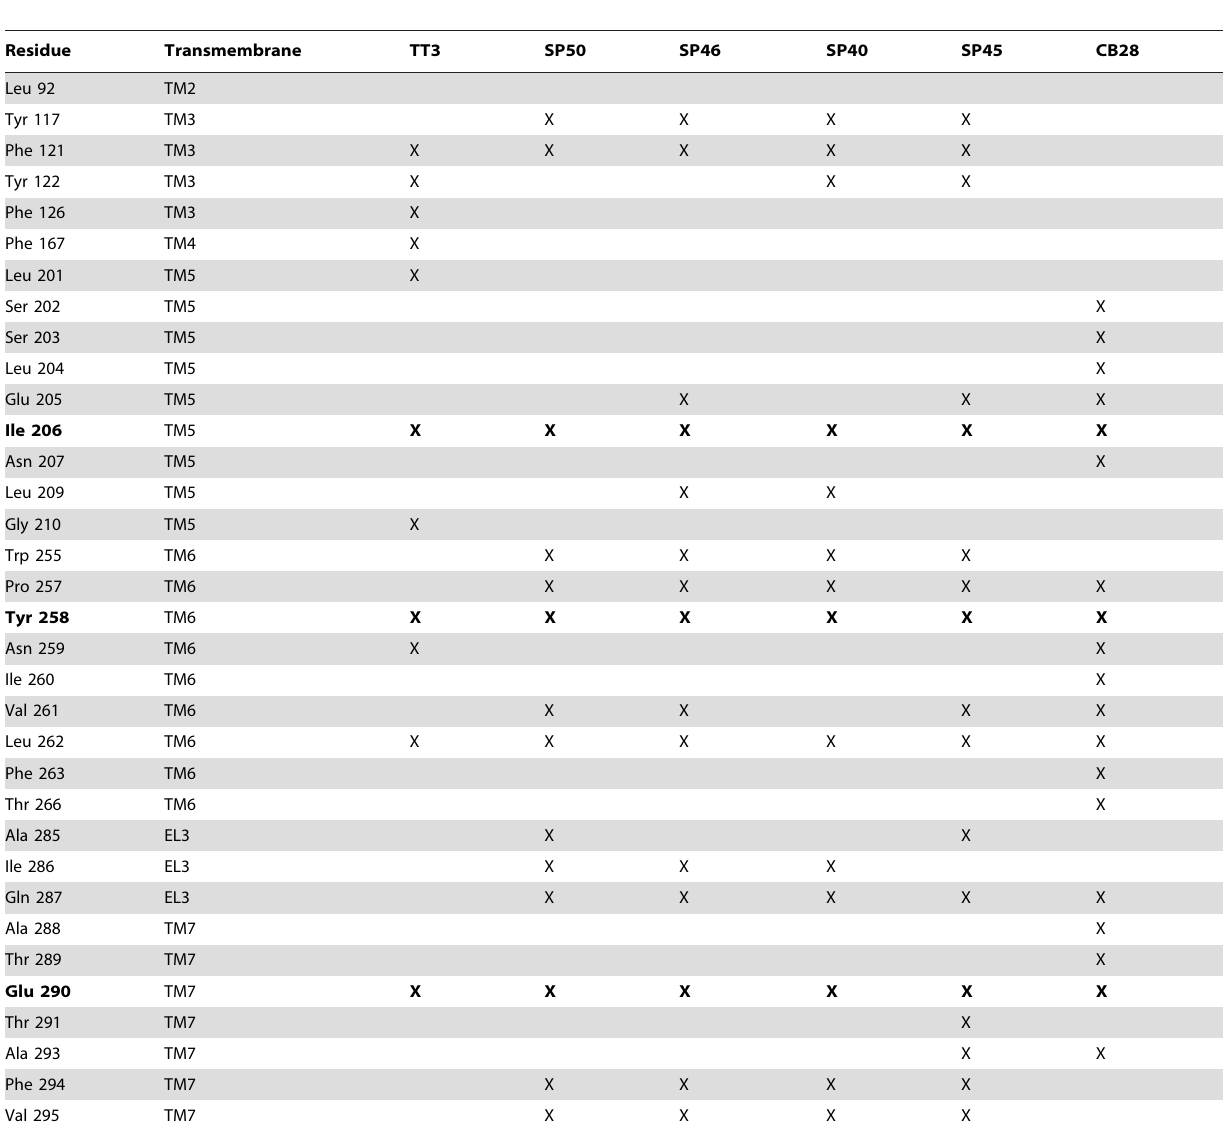
Table 3. Contact residues for the eight selected small molecules. All residues contain are within 4 A˚ of a ligand atom. Residues in bold are common to all six